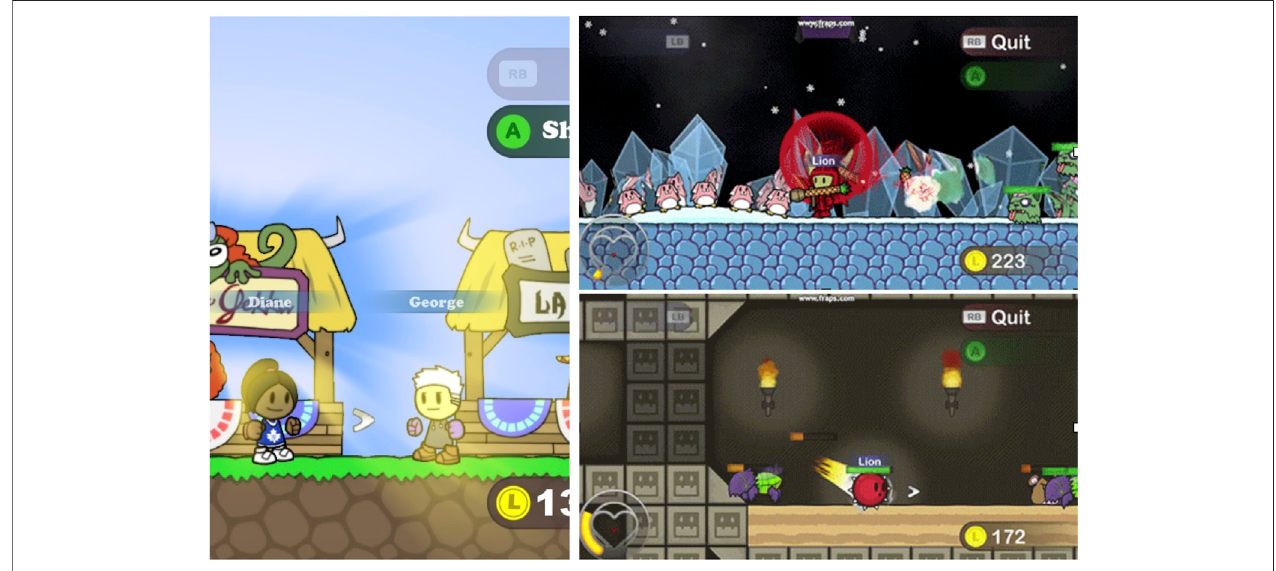
FIGURE 1 | Examples of the Liberi exergames. Top-right: Wiskin Defence: the player defends pink wiskins from attacking zombie cats using a pineapple gun; Bottom-right: DozoQuest:theplayer traversesamazeasaspikyball,encounteringanddefeatingenemies. Left: twoplayersmeetinthevillagewheretheycanchatand go shopping.